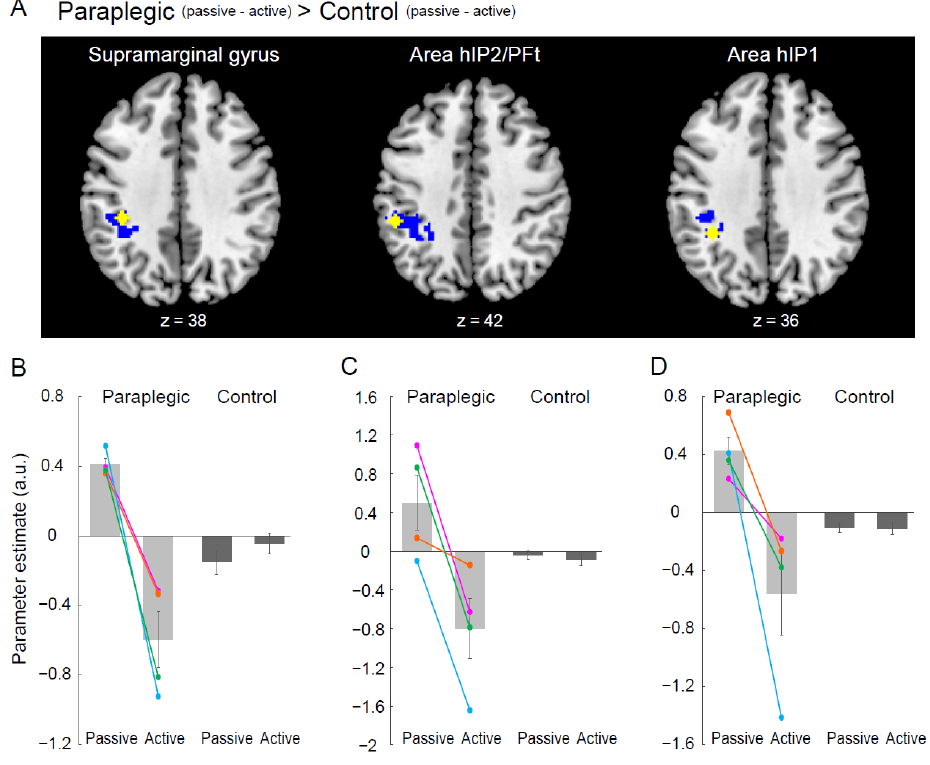
Figure 5. ( A ) The left IPS region showing a significant paraplegic group-specific difference between the passive and active tasks (paraplegic group (passive–active)–control group (passive–active)). The identified IPS region has three peaks in the supramarginal gyrus, area hIP2/PFt, and area hIP1, respectively. The IPS region (blue section) is superimposed on the transverse slices of the MNI brain ( x = 38, 42, and 36), with each peak plotted as a yellow dot. ( B – D ) Bar graphs show mean value of brain activity (parameter estimate) of each peak across participants for each task (yellow in each of paraplegic group (light gray) and control group (dark gray). Individual data from the paraplegic group are also plotted (pink, green, orange, and blue circles and lines represent the data obtained from P1, P2, P3, and P4, respectively). Lines on the bars indicate standard errors of the mean across participants. Abbreviations: a.u., arbitrary unit; IPS, intraparietal sulcus; MNI, Montreal Neurological